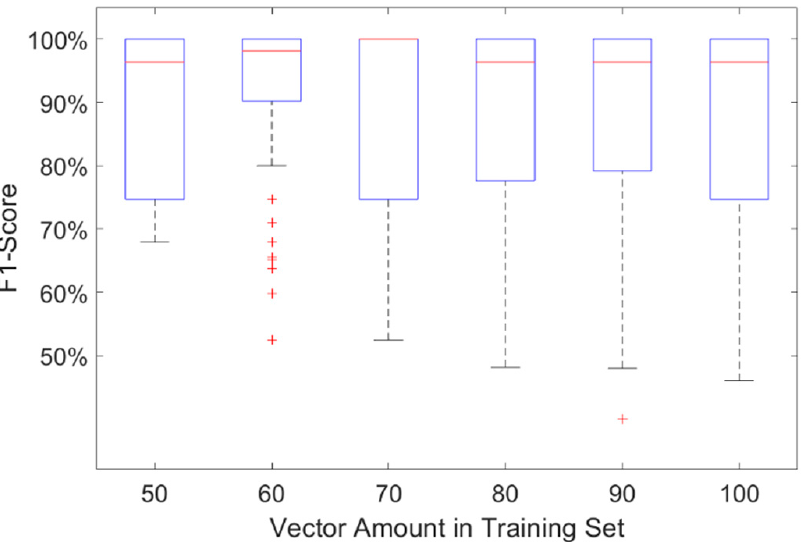
Figure 6. The effectiveness of the proposed mechanism in F 1 -score boxplots, tested using the Yelp dataset. The size of the training set is increased from 50 to 100 vectors, while the query set retained only 15 vectors. The best performance is achieved when the training set contains 60 re-engineered vectors, the performance starts to degrade with the addition of training vectors.